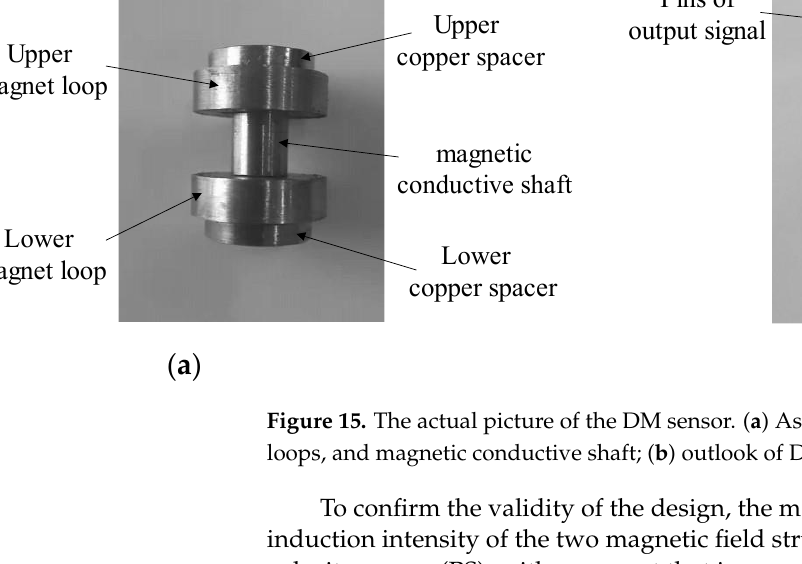
Figure 14. The opposite direction of the induced magnetic field. The solid red and solid blue represent two magnet loops with opposite magnetized directions.